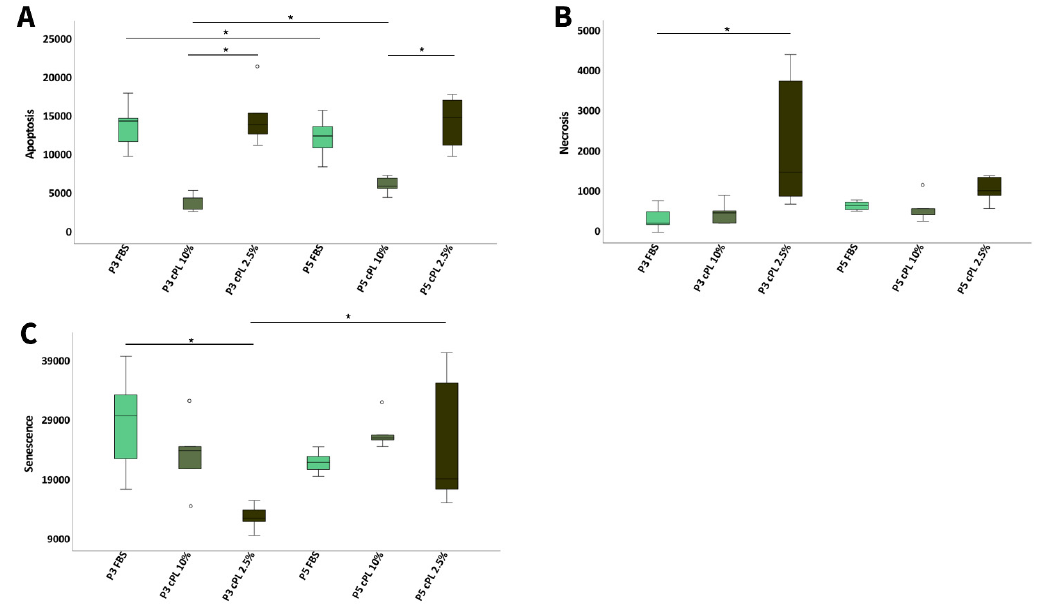
Figure 7. Apoptosis, necrosis, and senescence in canine cells. Boxplots display ( A ) apoptosis levels of canine mesenchymal stromal cells (MSC), measured by a luminescence-based Annexin V assay in passage 3 (P3) and 5 (P5) at day 5; ( B ) necrosis levels of canine MSC, measured using a cell- impermeant and pro-fluorescent DNA dye in passage 3 (P3) and 5 (P5) at day 5; ( C ) senescence levels of canine MSC in passage 3 (P3) and 5 (P5) at day 5, measured based on SA- β -galactosidase activity. Friedman tests for group comparisons and subsequent post hoc tests were performed; the asterisks indicate the significant differences between the corresponding groups (* corresponds to p < 0.05). Data were obtained using MSC from the same n = 5 donor dogs in each group.